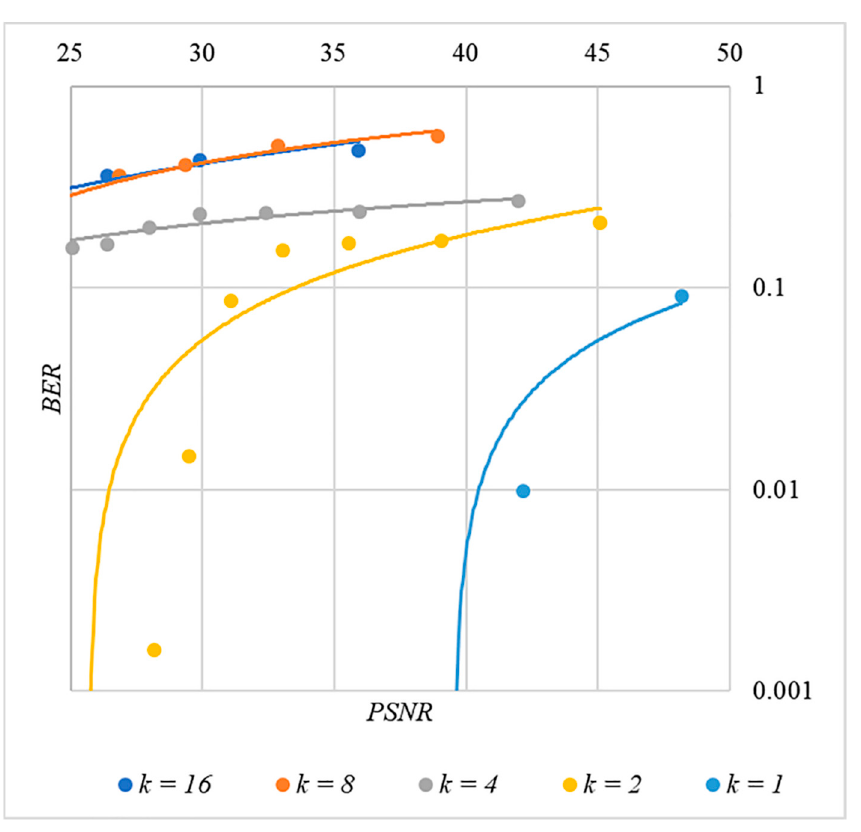
Figure 14. BER ( PSNR ) dependencies for different values k rule for generating chip codes № 2.